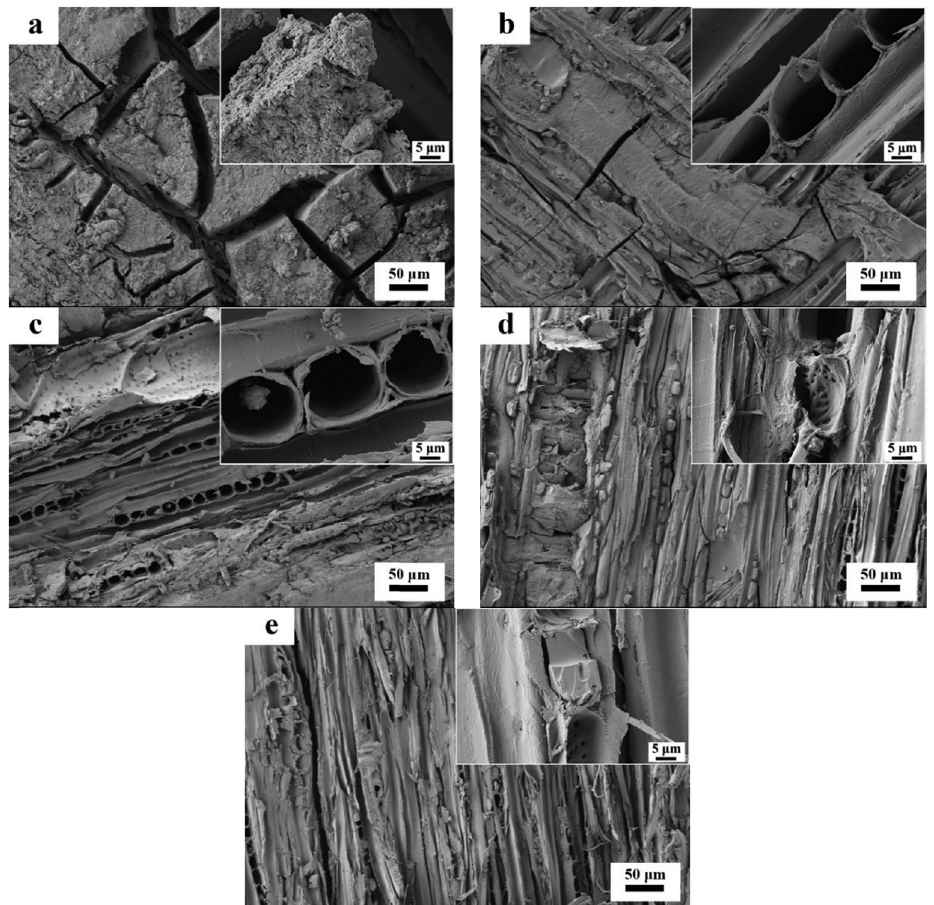
Figure 5: SEM images of bonded joints after the shear strength test of plywood: ( a ) GKLE - 10, ( b ) GKLE - 20, ( c ) GKLE - 30, ( d ) GKLE - 40, and ( e ) GKLE -